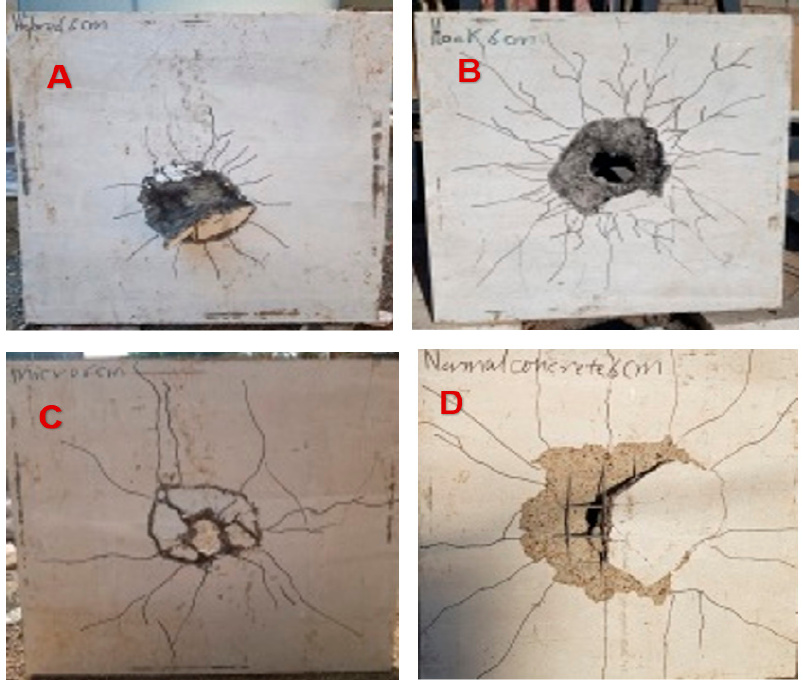
Figure 12. Failure patterns of ( A ) SIFCON slab with hybrid steel fibres, ( B ) SIFCON slab with hook- end steel fibres, ( C ) SIFCON slab with micro steel fibres, and ( D ) NSC slabs from the bottom under impact loading.